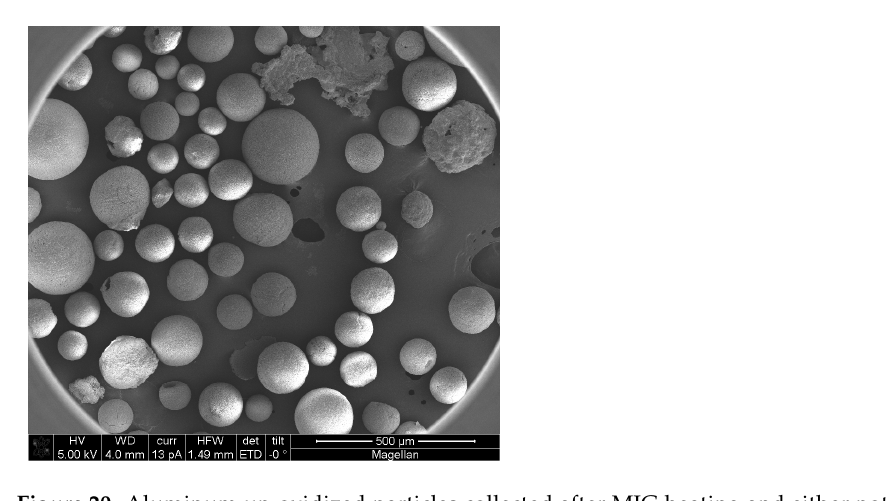
Figure 20. Aluminum un-oxidized particles collected after MIG heating and either not ignited, or ignited and quenched on stainless steel plate.